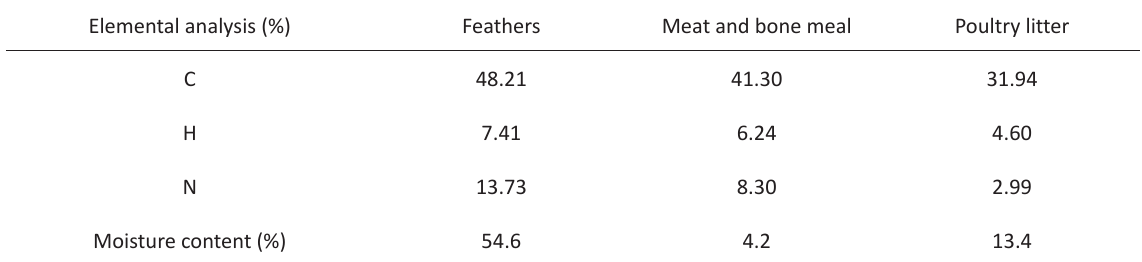
Moisture content